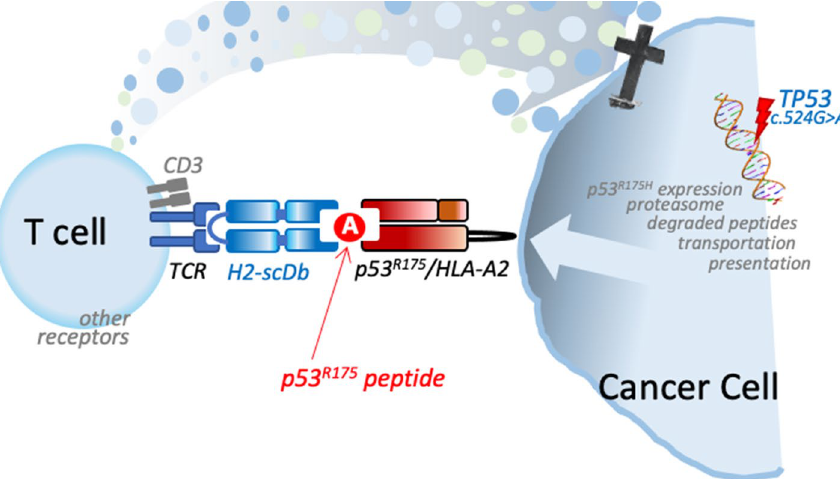
Fig. 1 Schematic representation of the mechanism of action of scDb against mutant p53. Tumour cells as able to express on their surface specific peptides, including the R175H mutation of p53, presented by the HLA complex. The Bi-Specific Ab bridging T cells and tumour cell, H2-scDb (blue), includes a TCR arm as well as a p53R175 peptide complex arm. This binds via the p53R175 peptide (red), the peptide presenting complex (dark red/black). Therefore, the tumour cells to the T-cells can be bridged the HLA complex, and on the other arm the CD3/TCR complex from the T lymphocytes. Activation of the T-cell results in killing of the cancer cells, mediated by the release of cytotoxic molecules; in particular via the local cytokine storm includes granzymes, perforin, TNF-a as well as IFN-g, able to activate the programmed cell death program of the cancer cell. The effect of granzymes are mostly exerted through cell–cell contact. scDb, single-chain diabody; HLA, human leukocyte antigen; TCR, T cell Receptor; CD3, cluster of differentiation 3; IFNγ, Interferon gamma; TNF-α, Tumour Necrosis Factor